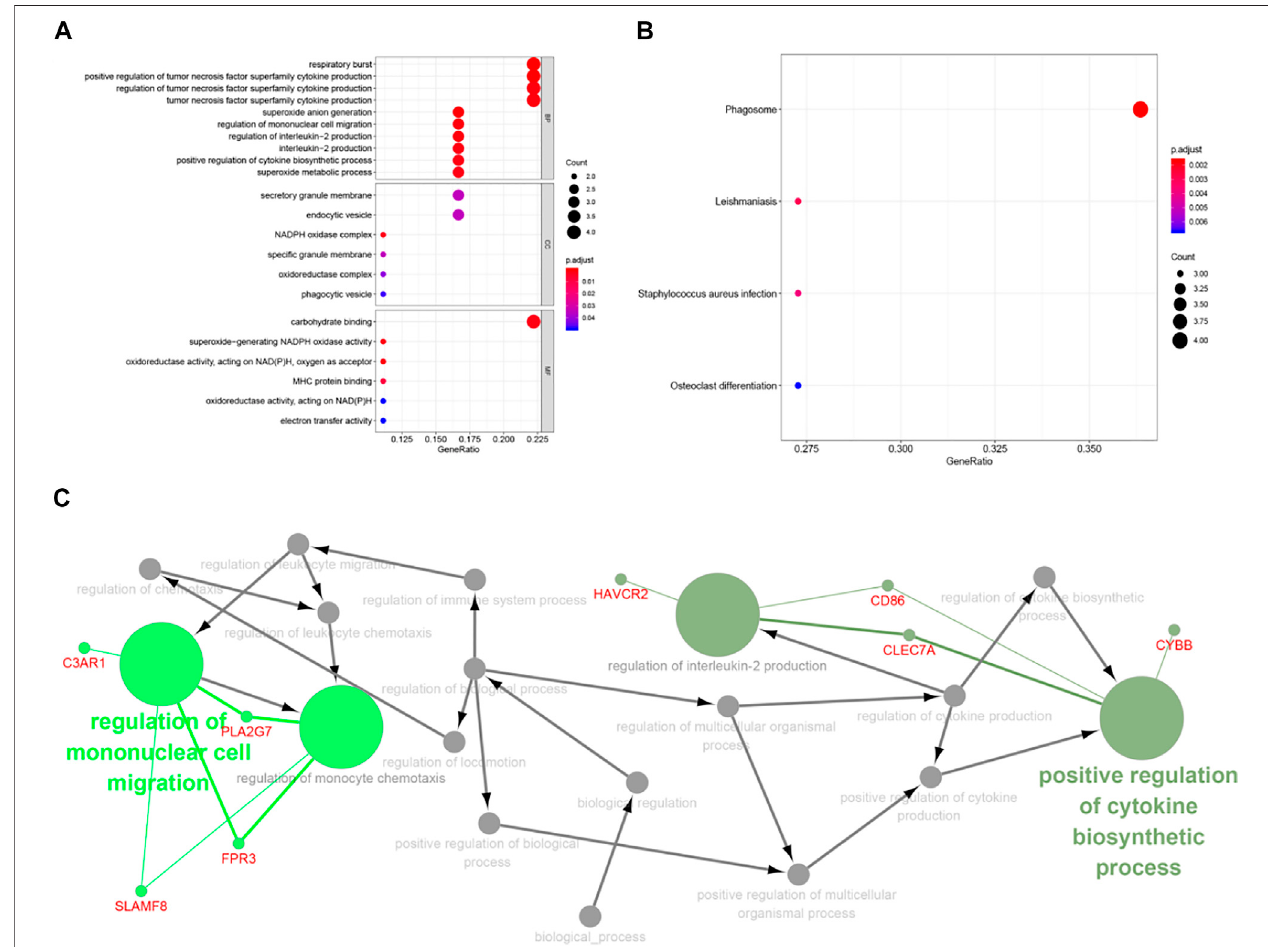
FIGURE 8| Functional enrichment ofkey genes. (A) The blue module wassigni fi cantly enriched in GO annotations. (B) The blue module wassigni fi cantly enriched in KEGG pathways. (C) Filtering the path with ClueGO.